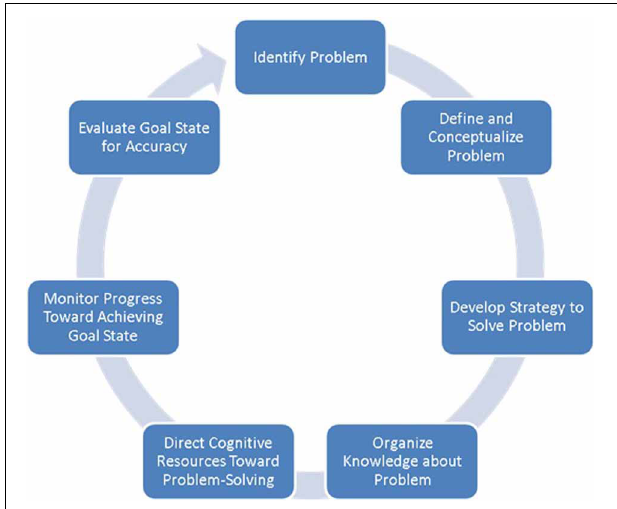
FIGURE 1 | Stages typically considered as part of the problem-solving cycle (adapted from Pretz et al.,